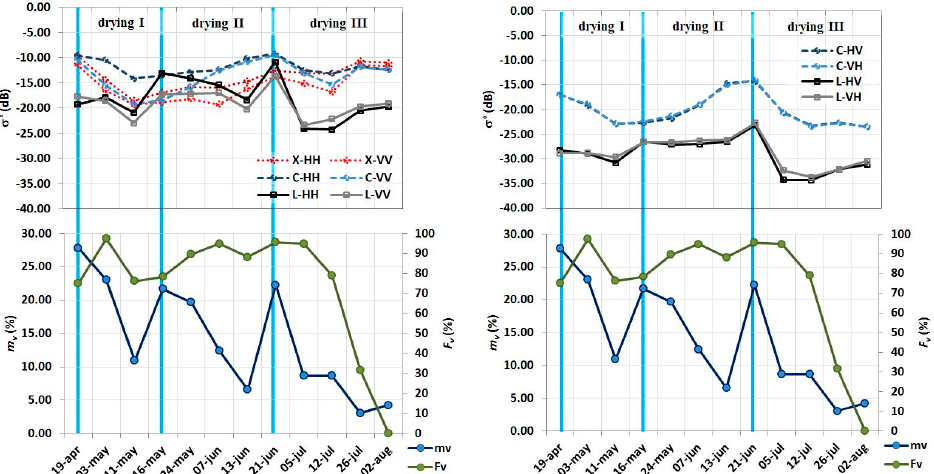
Figure 7. SVV ( m v and F v ) and σ ° temporal dynamics for the plot 450 (barley); co-polarized σ ° are shown in the upper left panel, whereas cross-polarized σ ° are in the upper right panel. Vertical blue bars mark m v peaks separating three consecutive drying periods.